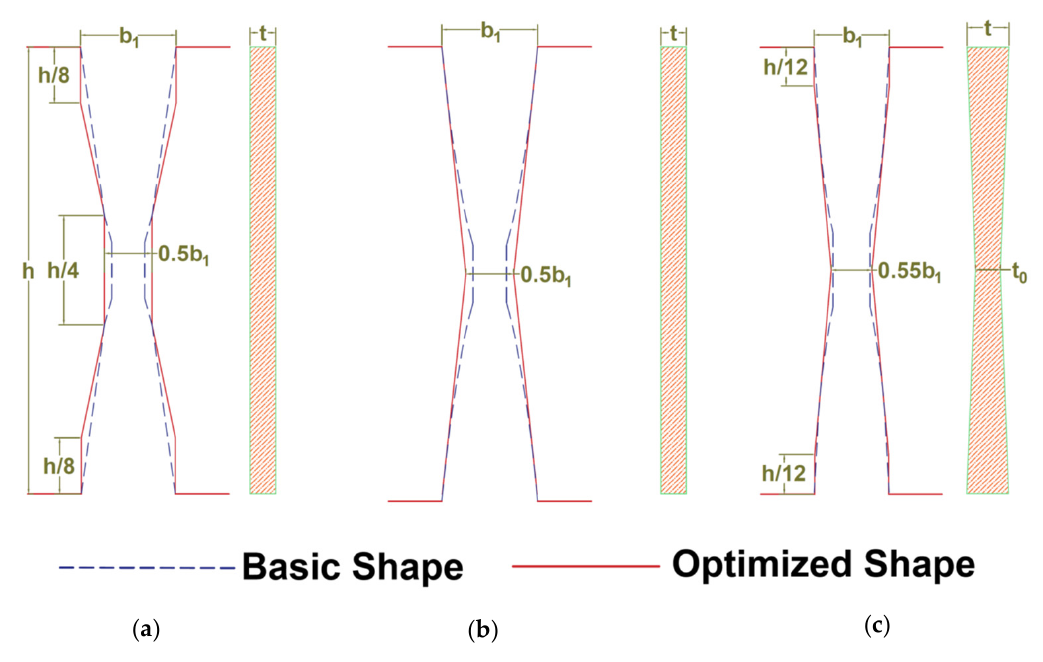
Figure 2. Non-uniform steel dampers [22].